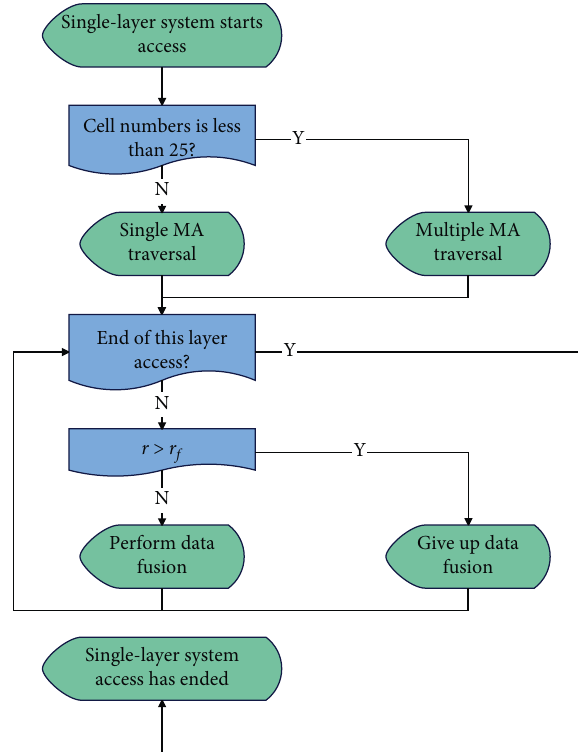
Figure 12: Flowchart of the 3D-PEMA algorithm.